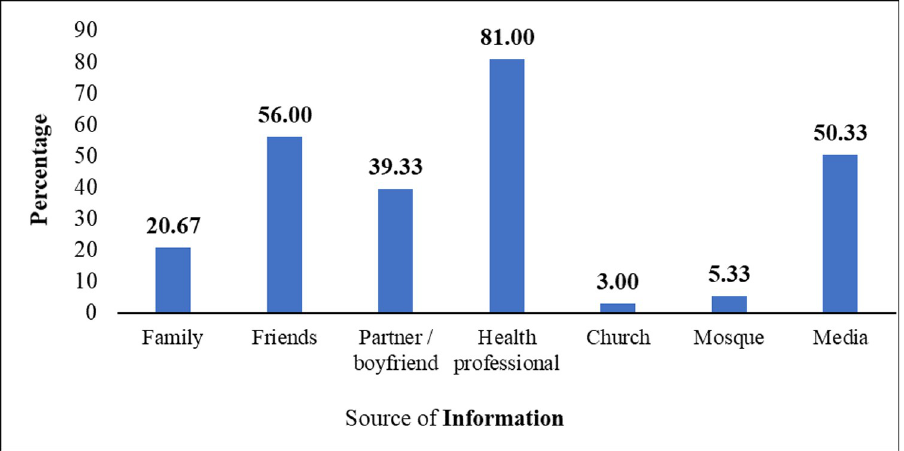
Fig 2. Respondents’ source of information about emergency contraception (n =